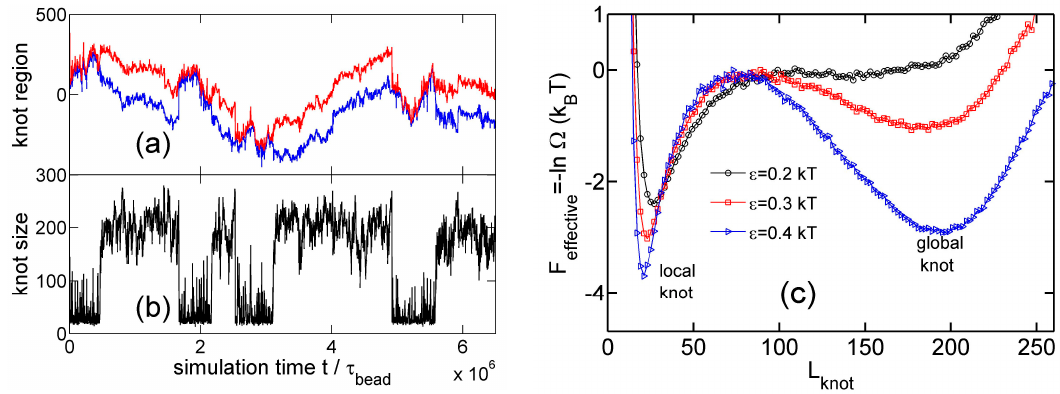
Figure 6. ( a ) The start (red line) and end (blue line) positions of a knot along a circular chain in a simulation {Yukawa potential, N m = 300, L p = 2.5 σ , κ − 1 = 5 σ , (cid:101) = 0.4 k B T }. The positions are occasionally offset by N m = 300 to make both curves continuous. ( b ) The number of beads in the knot core calculated from the plot in ( a ). ( c ) Effective potentials as a function of the knot size for three strengths of Yukawa potentials. We fix N m = 300, L p = 2.5 σ and κ − 1 = 5 σ